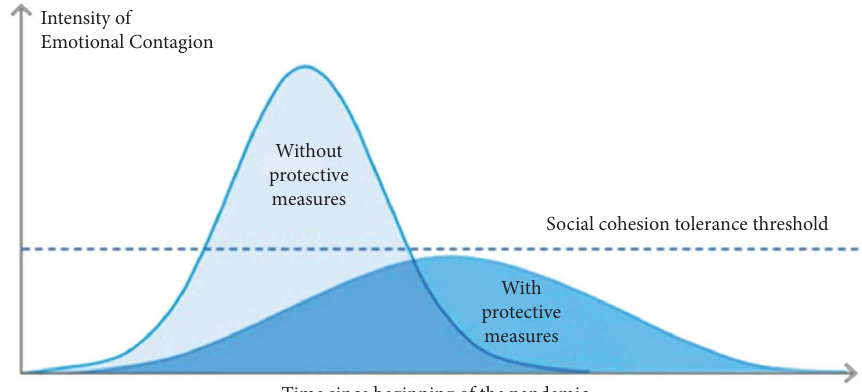
Figure 1: “Flattening the curve” of emotional